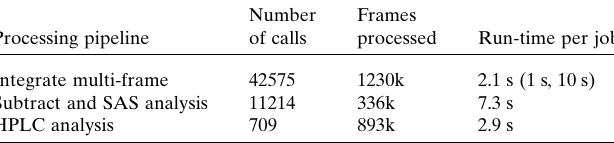
Table 2 Statistics of the number of job run over 20